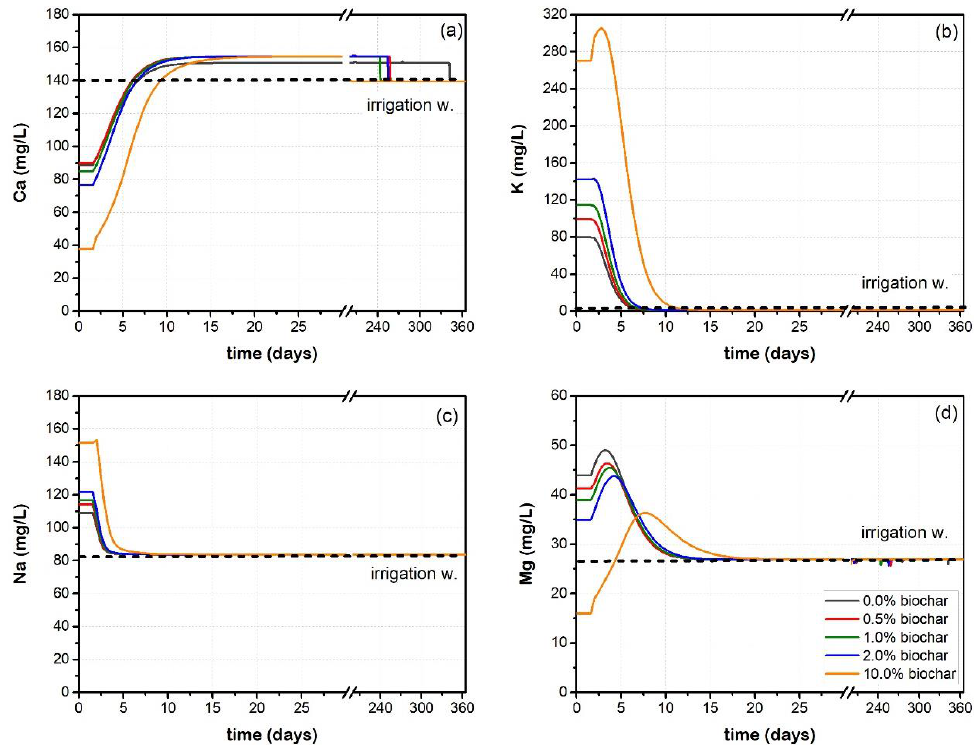
Figure 2. Elution curves of ( a ) Ca, ( b ) K, ( c ) Na and ( d ) Mg versus time as obtained from E.E. Model